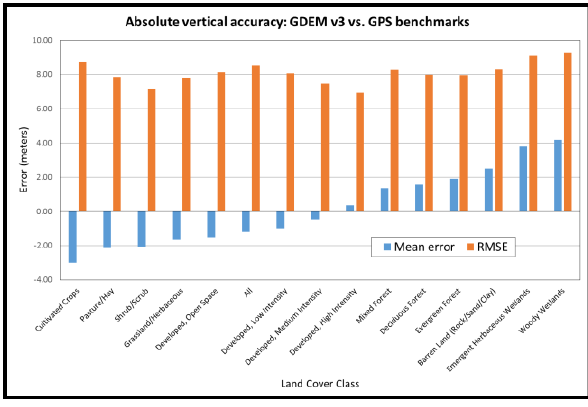
Figure 4. GDEM v3 mean error and RMSE by land cover class.